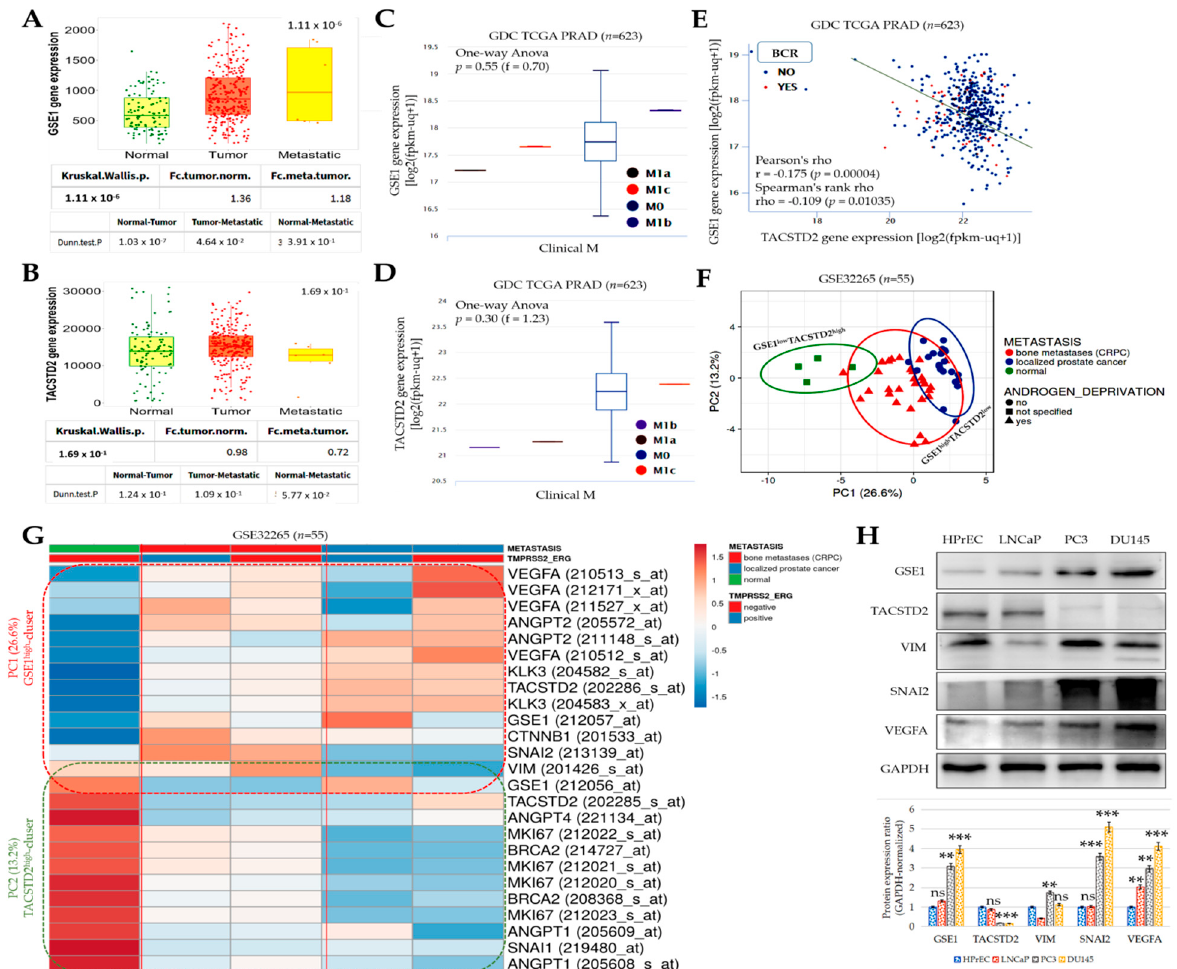
Figure 2. The interaction between GSE1 and TACSTD2 drives metastatic disease, castration resistance, and disease progression in patients with prostate cancer. Box-and-dot plots showing the differential expression of ( A ) GSE1 and ( B ) TACSTD2 genes in normal, tumor, and metastatic samples from the TCGA PRAD cohort. Box-and-whisker plots showing the correlation between ( C ) GSE1 or ( D ) TACSTD2 gene expression and clinical M stage in the TCGA PRAD dataset. ( E ) Graphical representation of the correlation between GSE1 and TACSTD2 gene expression levels. ( F ) Principal component analysis of the expression data for primary localized PCa vs. castration-resistant bone metastatic prostate cancer in the GSE32265 cohort. Unit-variance scaling was applied to rows; SVD with imputation was used to calculate principal components. X- and Y-axes show Principal Components 1 and 2, which explain 26.6 and 13.2% of the total variance, respectively. Prediction ellipses were computed such that, with a probability of 0.95, a new observation from the same group would fall inside the ellipse. N = 55 data points. ( G ) Expression heatmap showing the relationship between metastasis, the TMPRSS2-ERG fusion gene, and expression of GSE1, TACSTD2, KLK3/PSA, and biomarkers of angiogenesis, metastasis, and proliferation in the GSE32265 cohort. Columns with similar annotations were collapsed by taking the mean in each group. Rows are centered; unit-variance scaling was applied to rows. Both rows and columns were clustered using correlation distance and average linkage, with 25 rows and 5 columns. ( H ) Representative Western blot images of the differential expression of GSE1, TACSTD2, VIM, SNAI2, and VEGFA proteins in HPrEC, LNCaP, PC3, or DU145 cells. GAPDH served as a loading control. FC, fold change; meta, metastatic; norm, normal; M, distant metastasis; M0, no distant metastasis; M1a, distant metastasis to non-regional lymph node(s); M1b, distant metastasis to bone(s); M1c, distant metastasis to other site(s) with or without bone disease; BCR, biochemical recurrence; SVD, singular value decomposition. ** p < 0.01; *** p < 0.001; ns, not